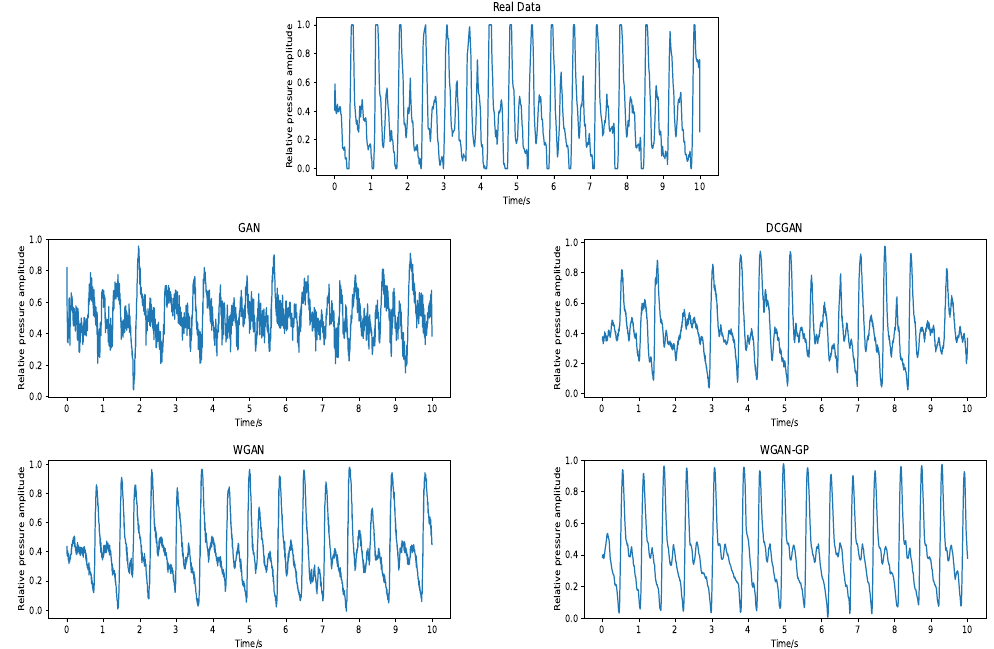
Figure 3. Example of the original and generated signals with different GAN models. In the figure, the real pulse data is shown above, and the false pulse generated by the corresponding GAN model is shown